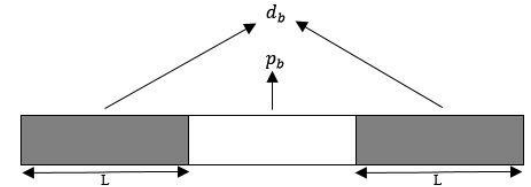
Fig. 3. Pilot Symbols are clustered in the center of data packet (Method